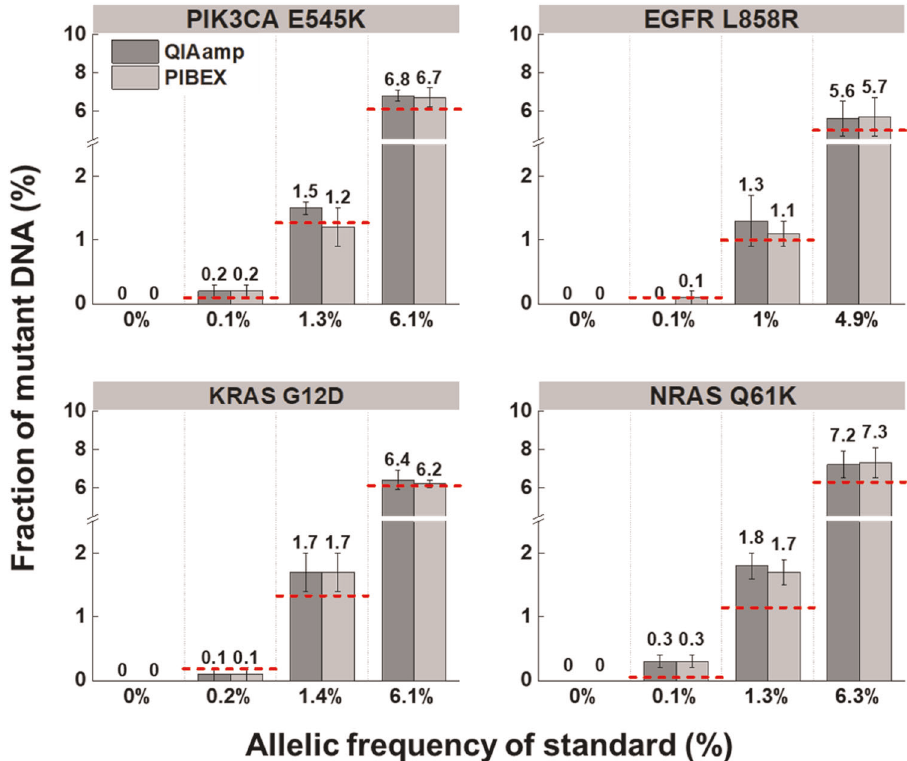
Fig. 4 Comparison analysis of ctDNA extraction between PIBEX chip and QIAamp using ddPCR. Standard ctDNA sample in synthetic plasma were extracted by QIAamp and PIBEX chip. Four mutations ( PIK3CA E545K, EGFR L858R, KRAS G12D, and NRAS Q61K) were measured by ddPCR. Prepared allelic frequency of standard ctDNA samples varied from 0 – 6.3% according to target variants. Red lines represent the expected fraction of mutant DNA for each experiment. The error bars indicate standard deviation ( n =